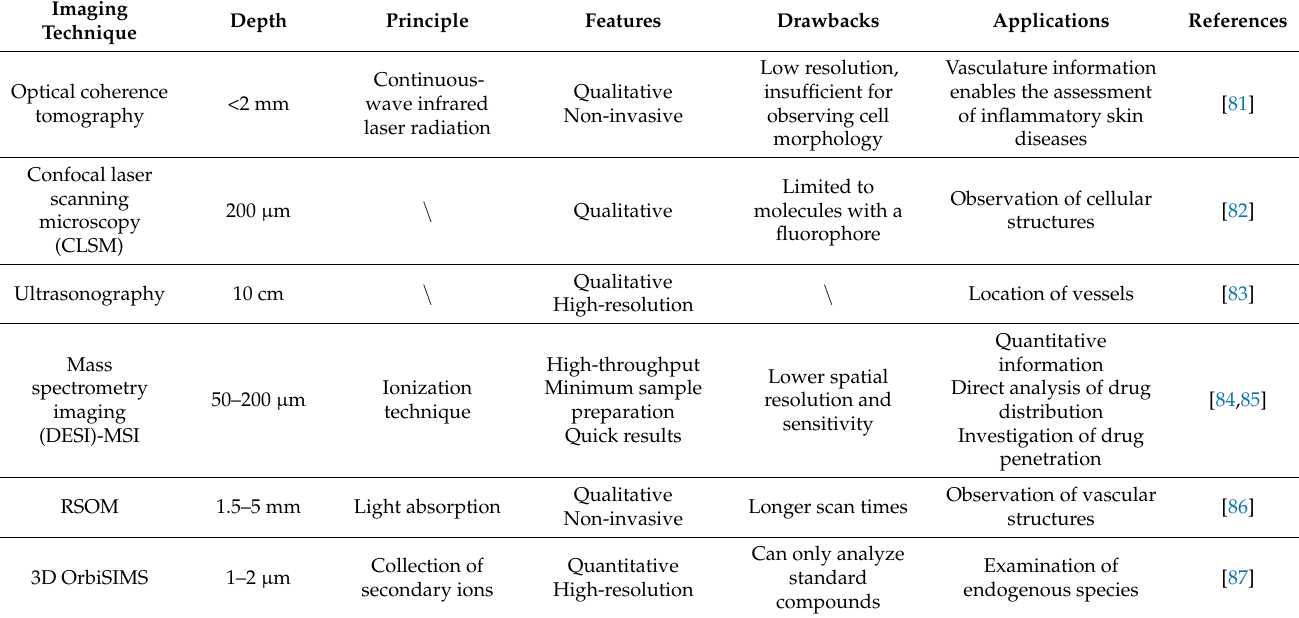
Table 3. Summary of skin